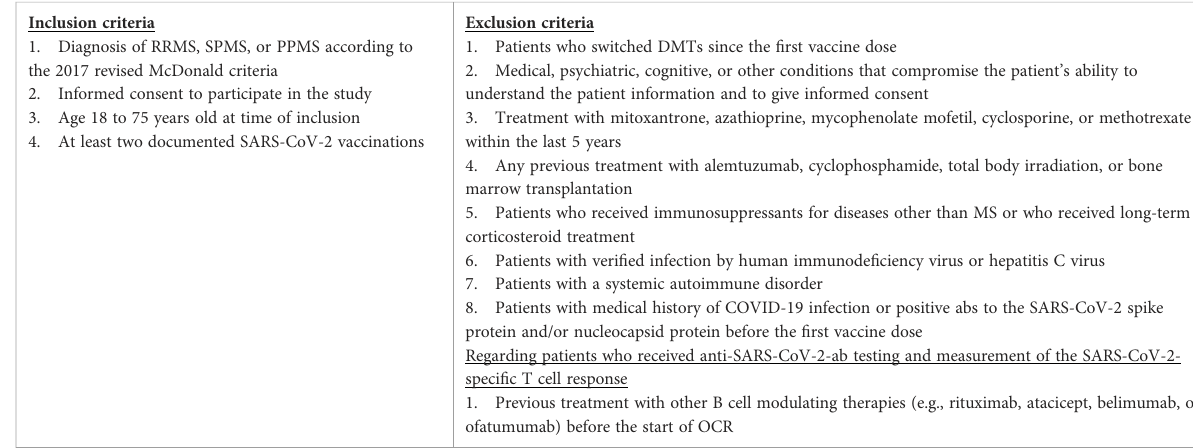
TABLE 1 Inclusion and exclusion criteria for MS